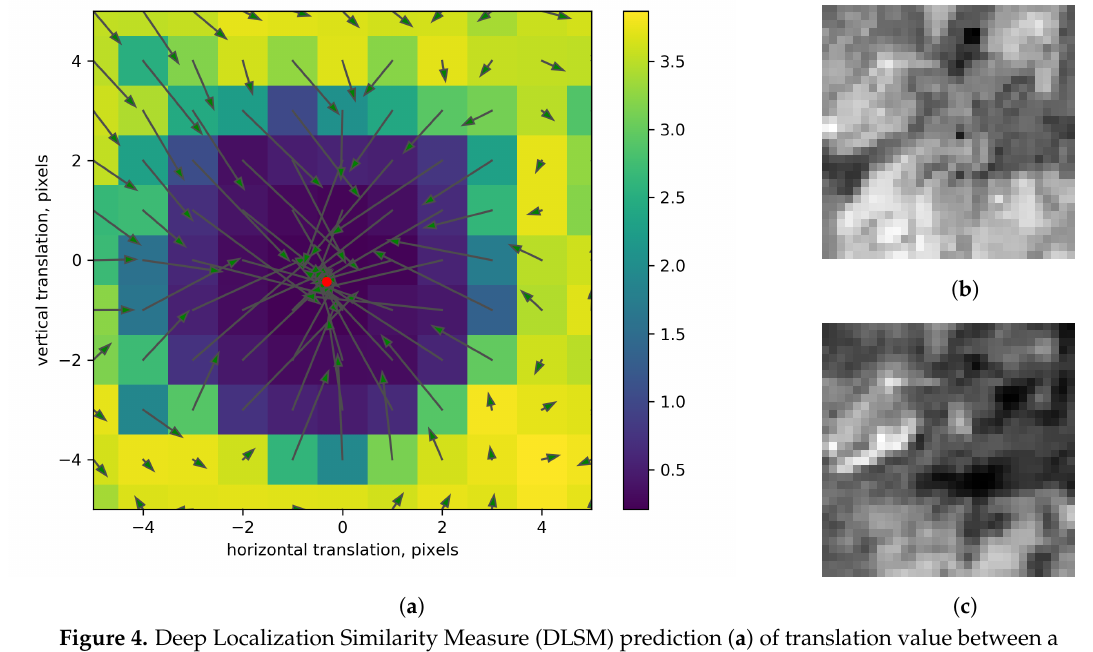
Figure 4. Deep Localization Similarity Measure (DLSM) prediction ( a ) of translation value between a patch pair: ( b ) reference patch and ( c ) template patch. The colorbar corresponds to the SM value. Each predicted translation vector is shown as an arrow starting in the input translation between patches and ended in predicted correspondence position. The true correspondence is marked by the red